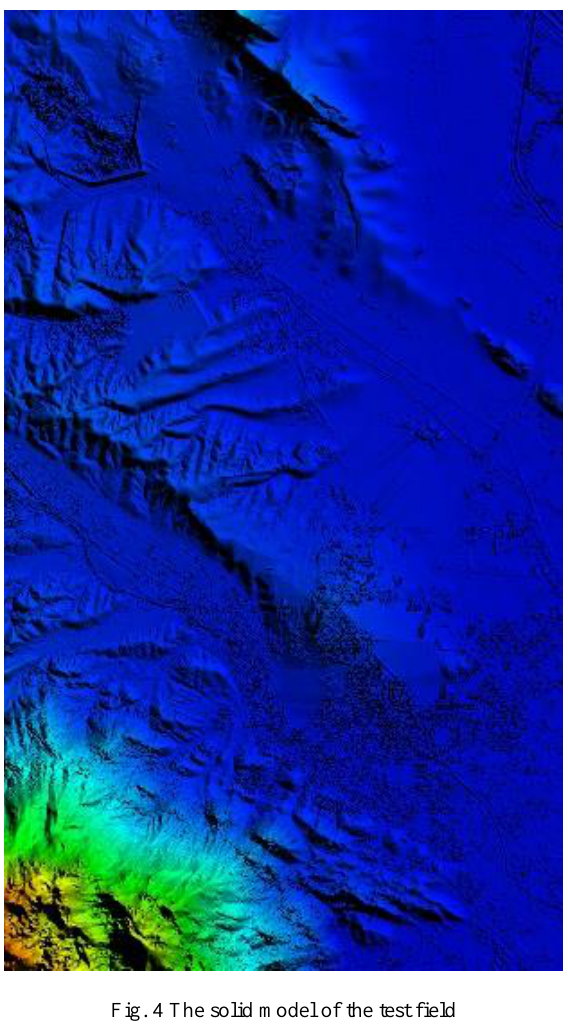
Fig. 4 The solid model of the test field